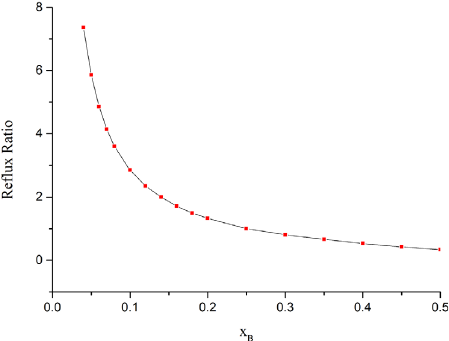
Fig. 2. Theoretical minimum re fl ux ratios vs . still pot concen- tration x B are required for a constant distillate composition of 90%